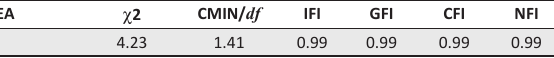
health outcomes.